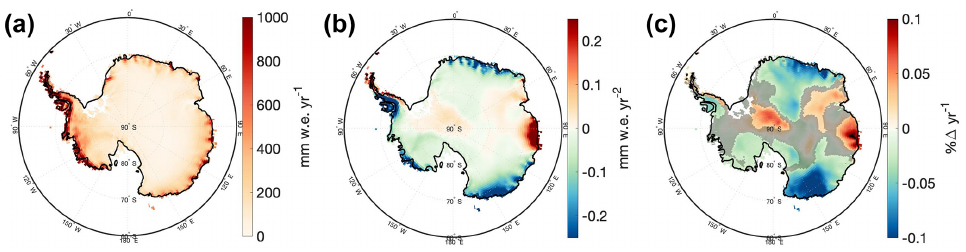
Figure 2. A spatial map of (a) the temporal average from 1801–2000 of the reconstructed AIS SMB, (b) the linear trend from 1801–2000 of the reconstructed AIS SMB, and (c) the relative SMB trend in percent SMB change per year. Non-shaded regions in panel (c) denote areas that are statistically